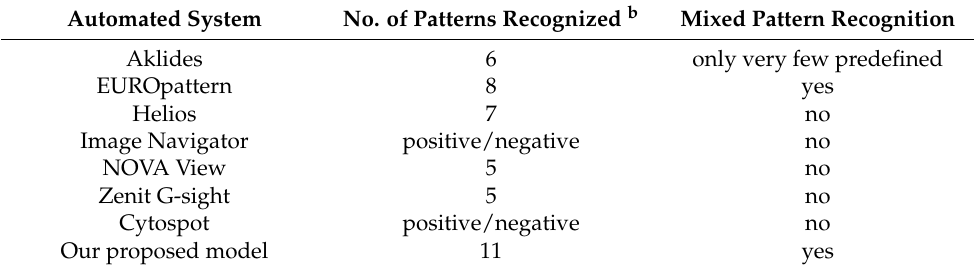
Figure 5. Examples of mixed pattern images that commonly leading to inconsistent reading. ( A ) High consistency of cytoplasmic staining pattern, but is inconsistent if there is a “nuclear fine speckled” pattern. ( B ) High consistency of nuclear centromere pattern, but is inconsistent if there is a “nuclear fine speckled” pattern. ( C ) High consistency of nuclear fine speckled pattern, but is inconsistent if there is a “cytoplasmic speckled” pattern, especially in very weak cytoplasmic staining images. Table 5. Characteristics of automated readers for Hep-2 image patterns identified by ANA IIF testing a